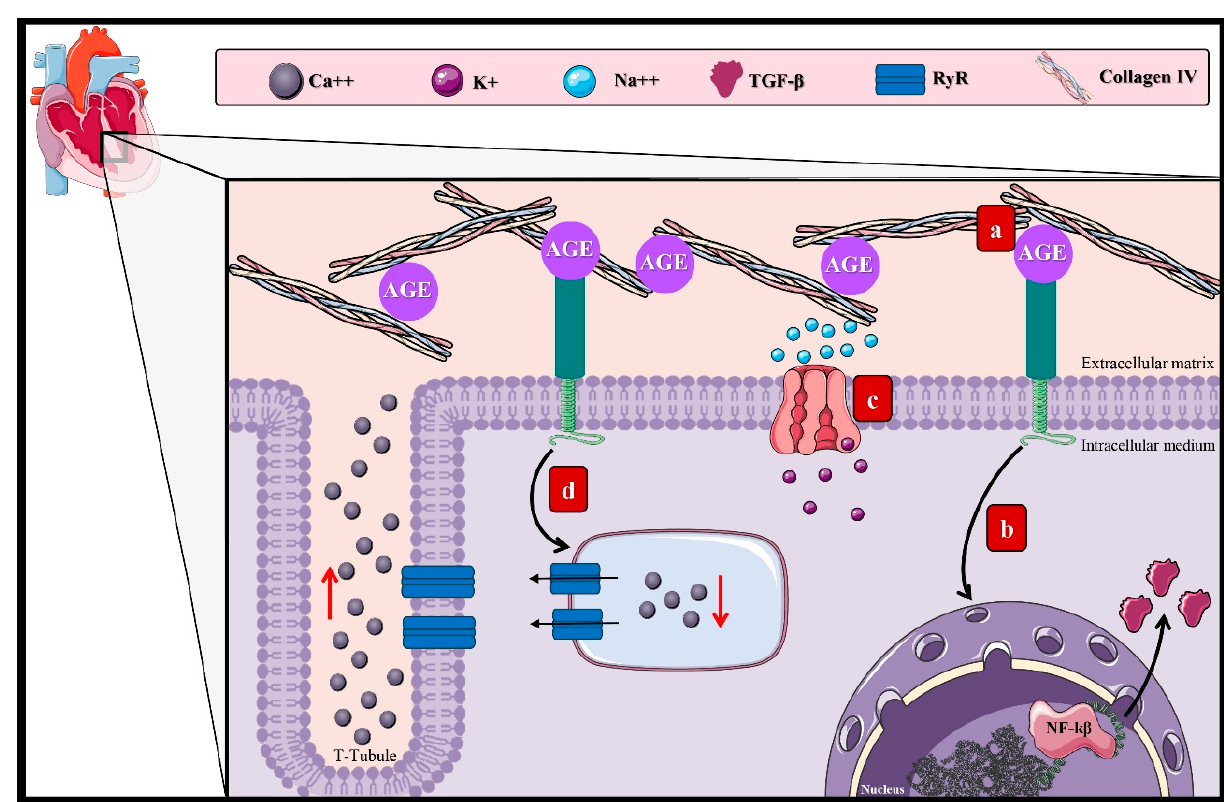
Figure 4. AGEs in diabetic cardiomyopathy. The effect of the AGEs in diabetic cardiomyopathy arises through diverse mechanisms: ( a ) accumulation in the extracellular matrix of cardiac tissue due to the interaction with structural proteins, inducing reticulation between collagen fibers and laminin and decreasing the elastic properties of the cardiac tissue. ( b ) Activation of the AGE–RAGE pathway by the induction of TGF- β and other proinflammatory cytokines that allow the proliferation of fibroblasts conducive to myocardial hypertrophy. ( c ) Activation of the AGE–RAGE pathway and ionic imbalance due to inhibition of the SIRT1/NAD+ pathway, disturbing the function of the Na ++ /K + ATPase. ( d ) Overstimulation of the RyR, generating irregular modifications of the Ca++ levels, favoring its exit and causing an alteration of the cardiac cycle that advances to diastolic dysfunction. Ca ++ : calcium, K + : potassium, Na ++ : sodium, TGF- β 1: transforming growth factor β , and RyR: ryanodine receptors.